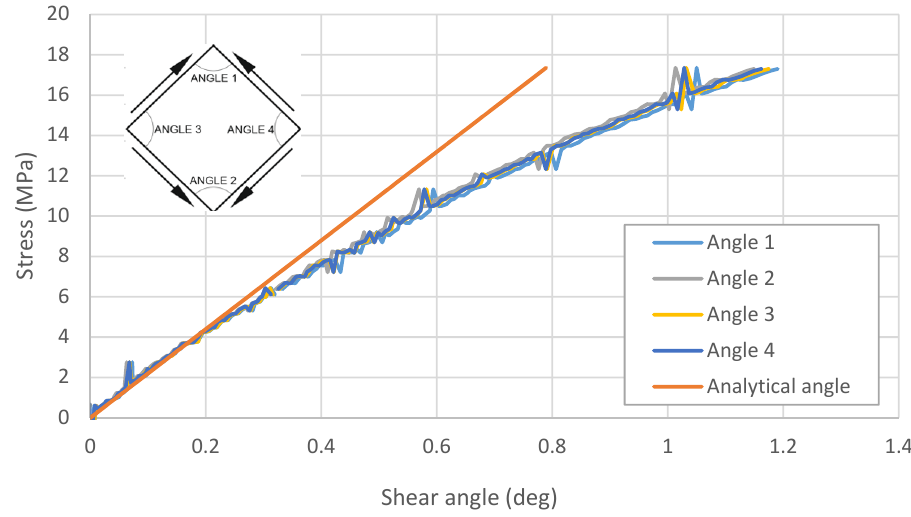
Figure 8. Relationship between the measured values of the shear strain angles and the value of the stress in the plate. The analytical angle was designated based on the value presented in Figure 9.